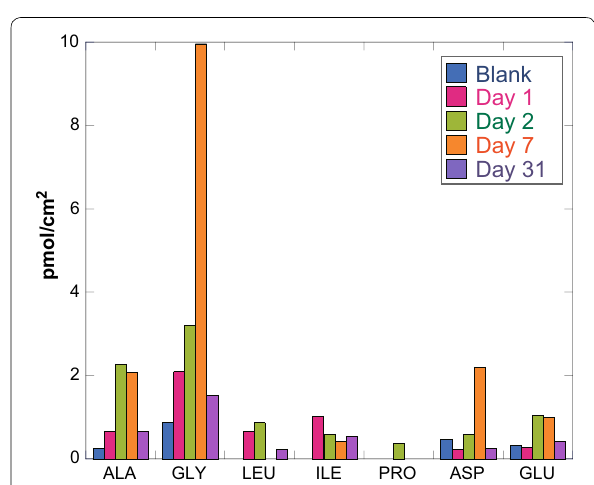
Fig. 4 A bar chart showing the quantification results of amino acids on the witness